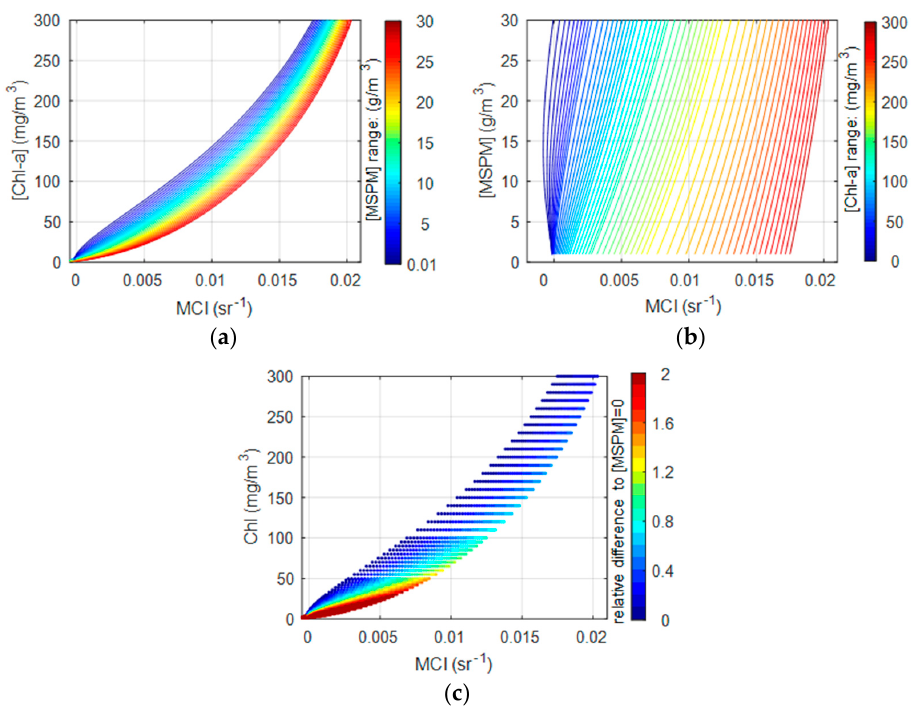
Figure 3. The impact of MSPM on the MCI-[Chl-a] relationship. ( a ) MCI-[Chl-a] relationship from simulated R rs ; each isoline indicating a constant [MSPM] in the range of 0.1 to 30 g/m 3 according to the colored legend. ( b ) [MSPM]-MCI relation with a [Chl-a] colored legend, and ( c ) [Chl-a] residuals relative to the MCI:[Chl-a] relationship at [MSPM] = 0.